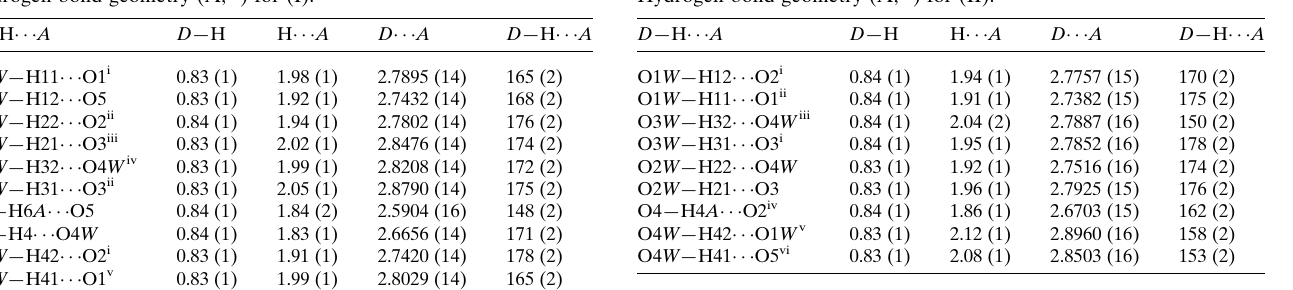
Table 2 Hydrogen-bond geometry (A˚ , (cid:3) ) for (II).